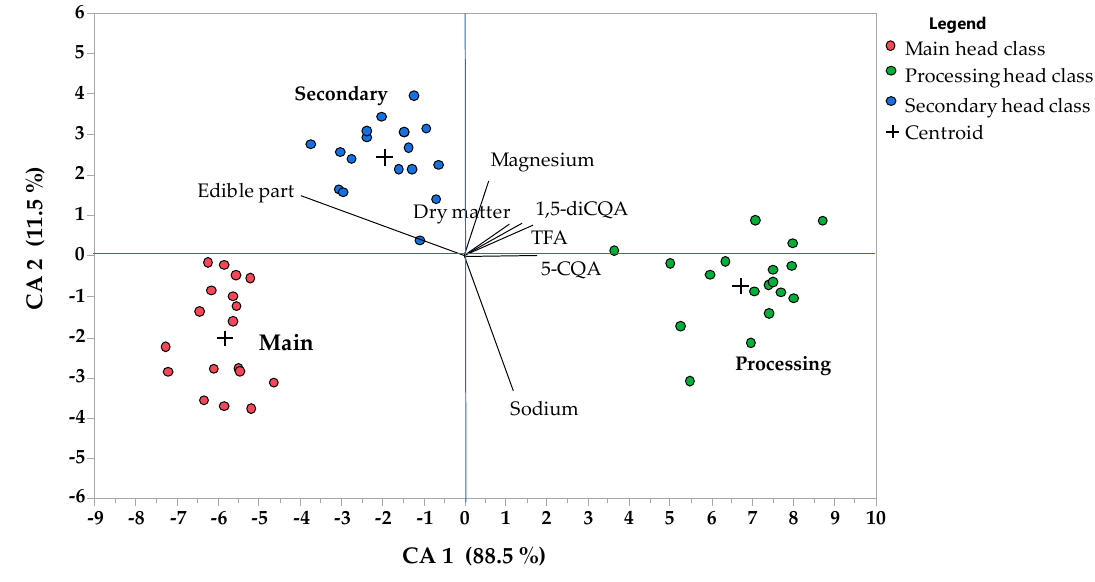
Figure 3. Stepwise discriminant analysis biplot of the quality parameters of artichoke heads considering the head class factor as the discriminant variables. For each data point, the head class names are included. 5-CQA: 5- O -ca ff eoylquinic acid (chlorogenic acid); 1,5-diCQA: 1,5-di- O -ca ff eoylquinic acid.